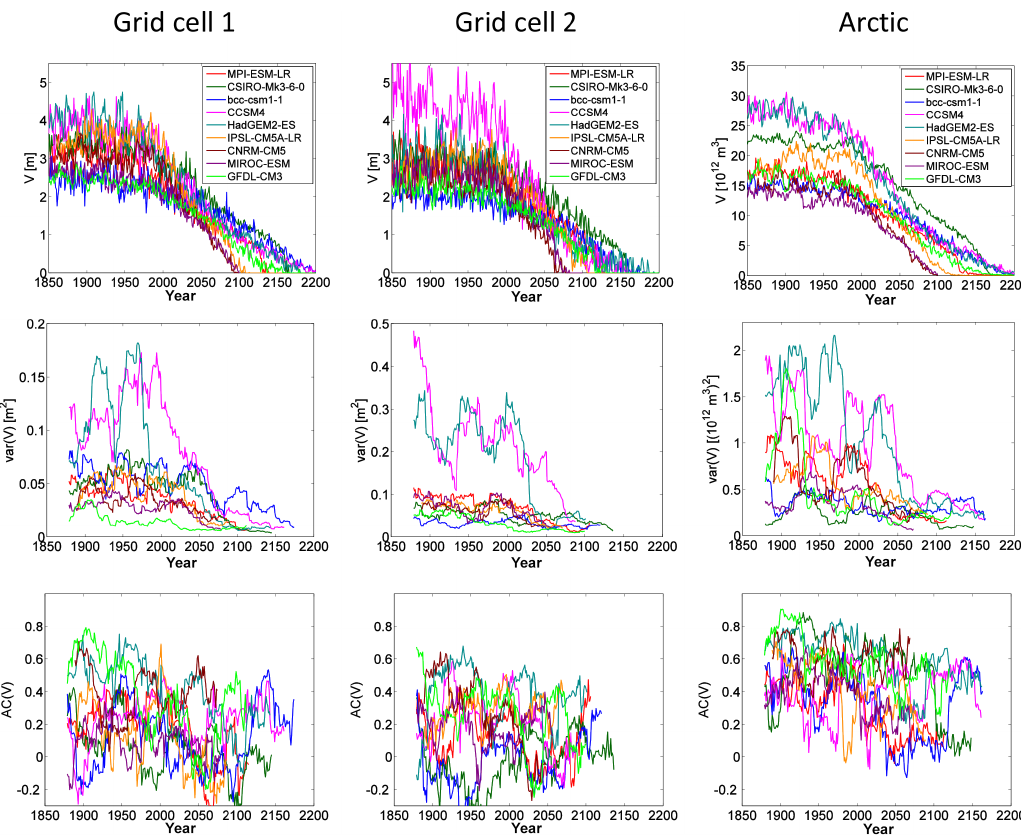
Figure 8. Evolution of MAM-averaged sea-ice volume ( V ) and its variance (var) and autocorrelation (AC) in nine comprehensive climate models. The time series are the combined historical and RCP8.5 simulation; the window length for the calculation of var and AC is 30 years. Grid cell 1 is located at approx. 102 ◦ W/86.5 ◦ N and grid cell 2 at 180 ◦ W/74.5 ◦ N; the right column shows all volume north of 75 ◦